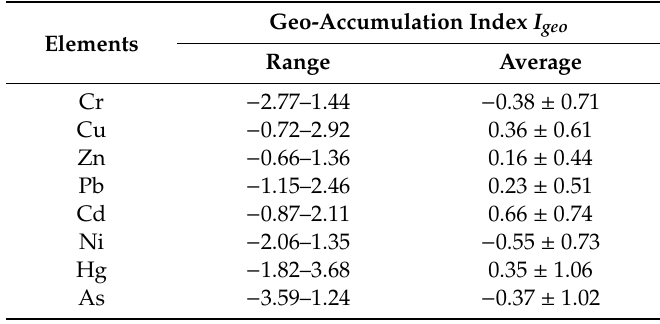
Figure 3. Distribution of the geo-accumulation index ( I geo ). Table 9. Values of the geo-accumulation index ( I geo ).